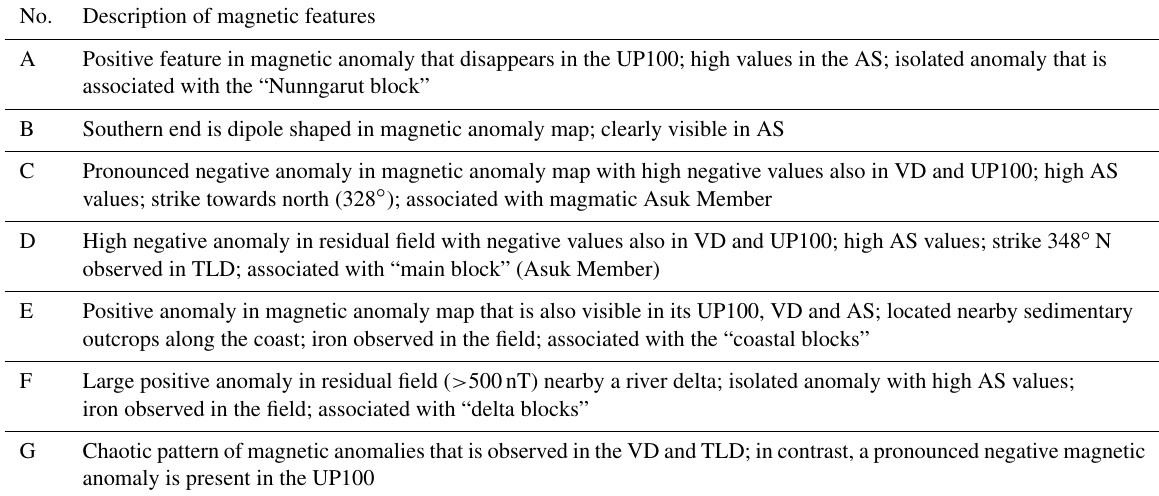
Table 1. Magnetic features identified in the residual magnetic anomaly (Fig. 3e) and its associated derivates (Fig. 4).